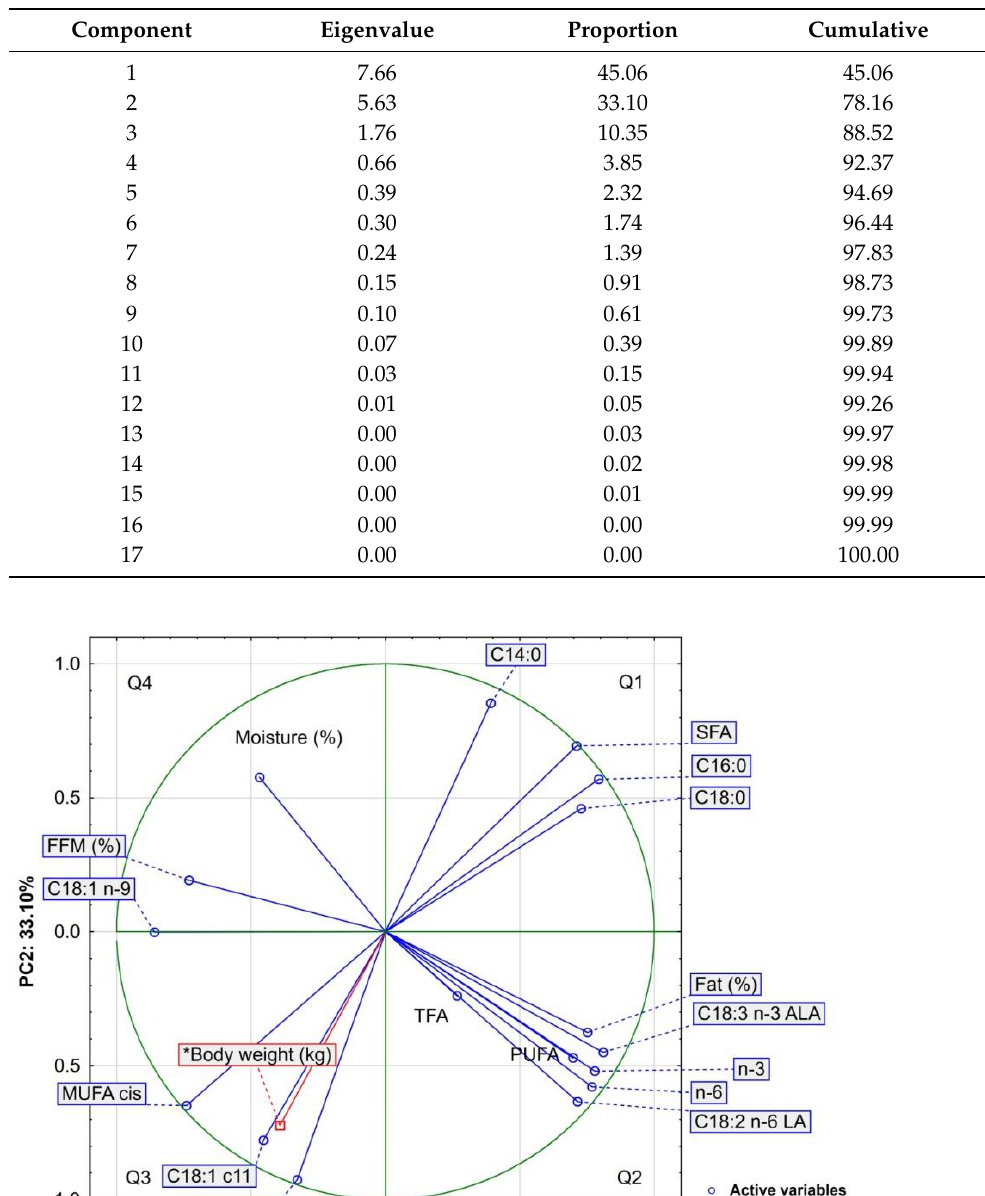
Table 4. Eigenvalues and the proportion of variation (%), as explained by the principal components.